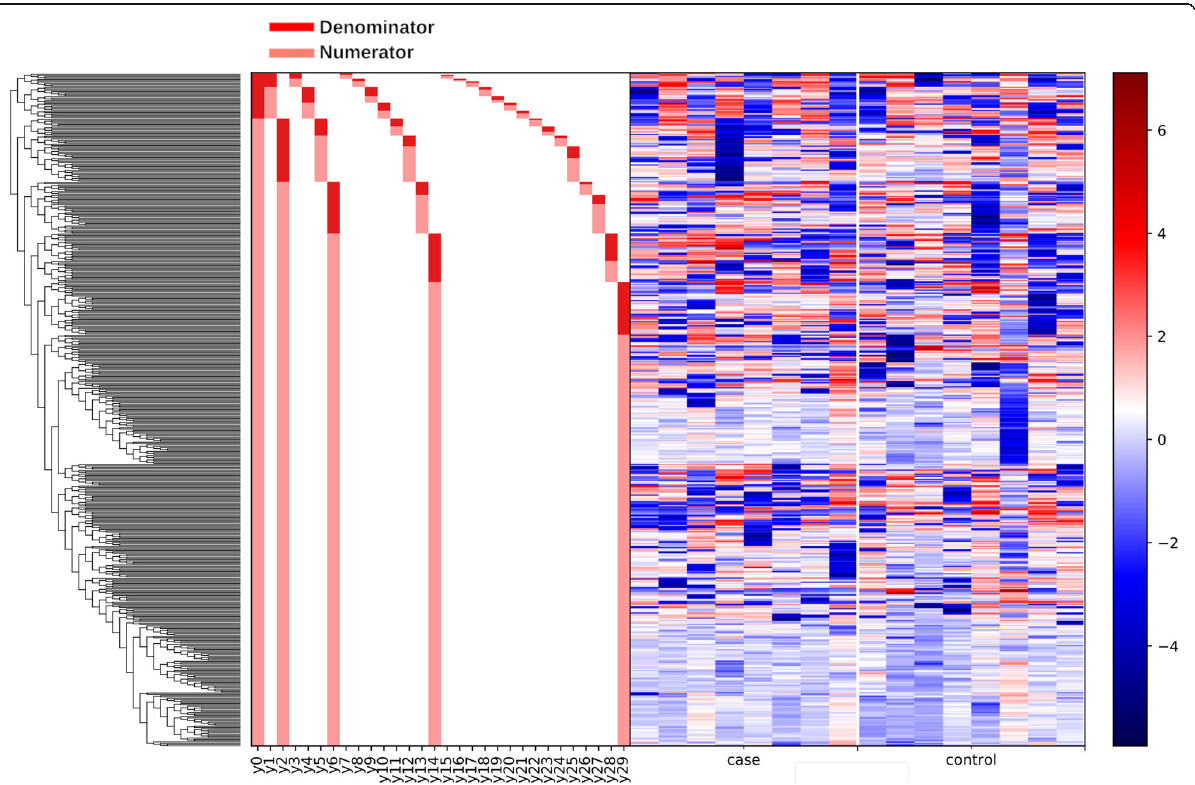
Fig. 13 Dendogram heatmap showing log 10 abundance of ASV in the foot microbiota of samples taken from healthy sheep ’ s feet that did (case) or did not (control) develop CODD in the